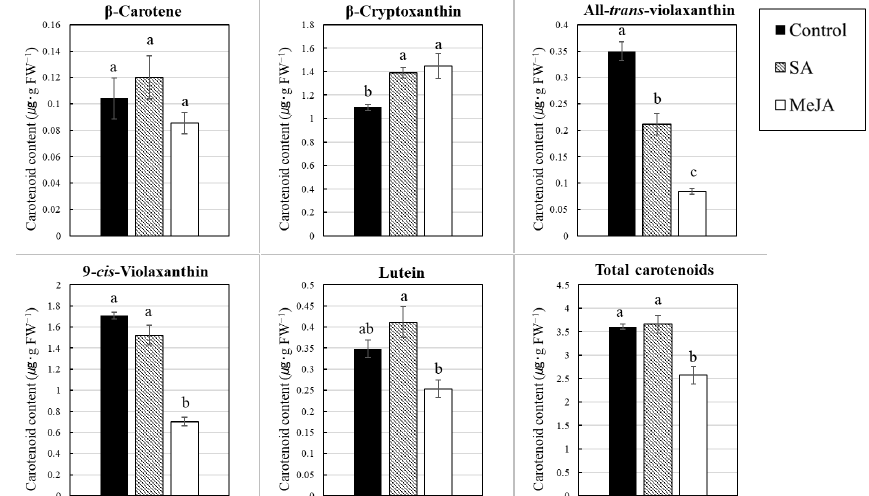
Figure 2. Effect of salicylic acid (SA) and methyl jasmonate (MeJA) treatments on the carotenoid content in the juice sacs of Satsuma mandarin in vitro. The total carotenoid was calculated by summing β-carotene, β-cryptoxanthin, all- trans -violaxanthin, 9- cis -violaxanthin, and lutein. Columns and bars represent the means and SE ( n = 3), respectively. Different letters indicate significant differences at the 5% level by Tukey’s HSD test.